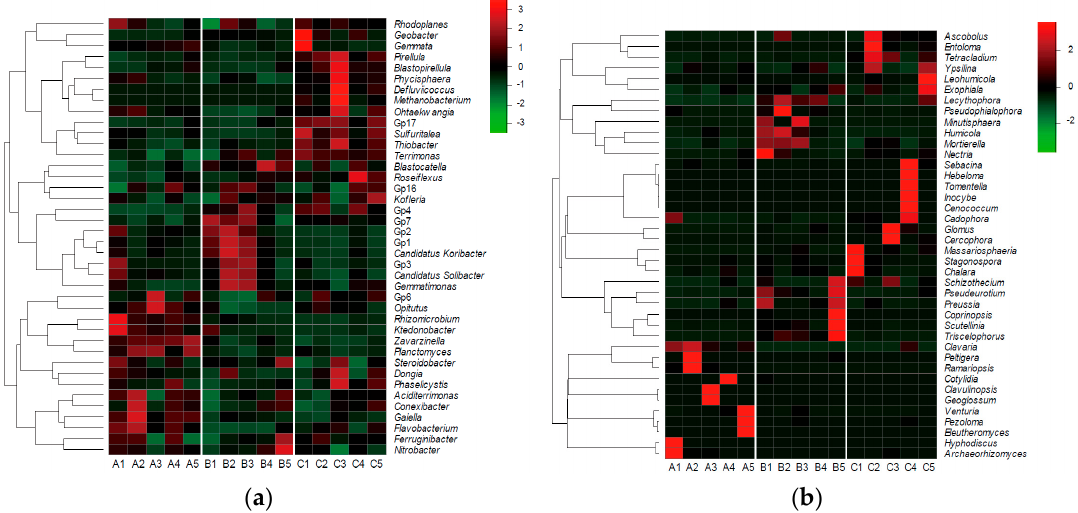
Figure 4. Relative abundance of ( a ) bacterial and ( b ) fungal phyla in different sites. “Other” includes phyla with less than 0.1% of relative abundance and unclassified phyla.